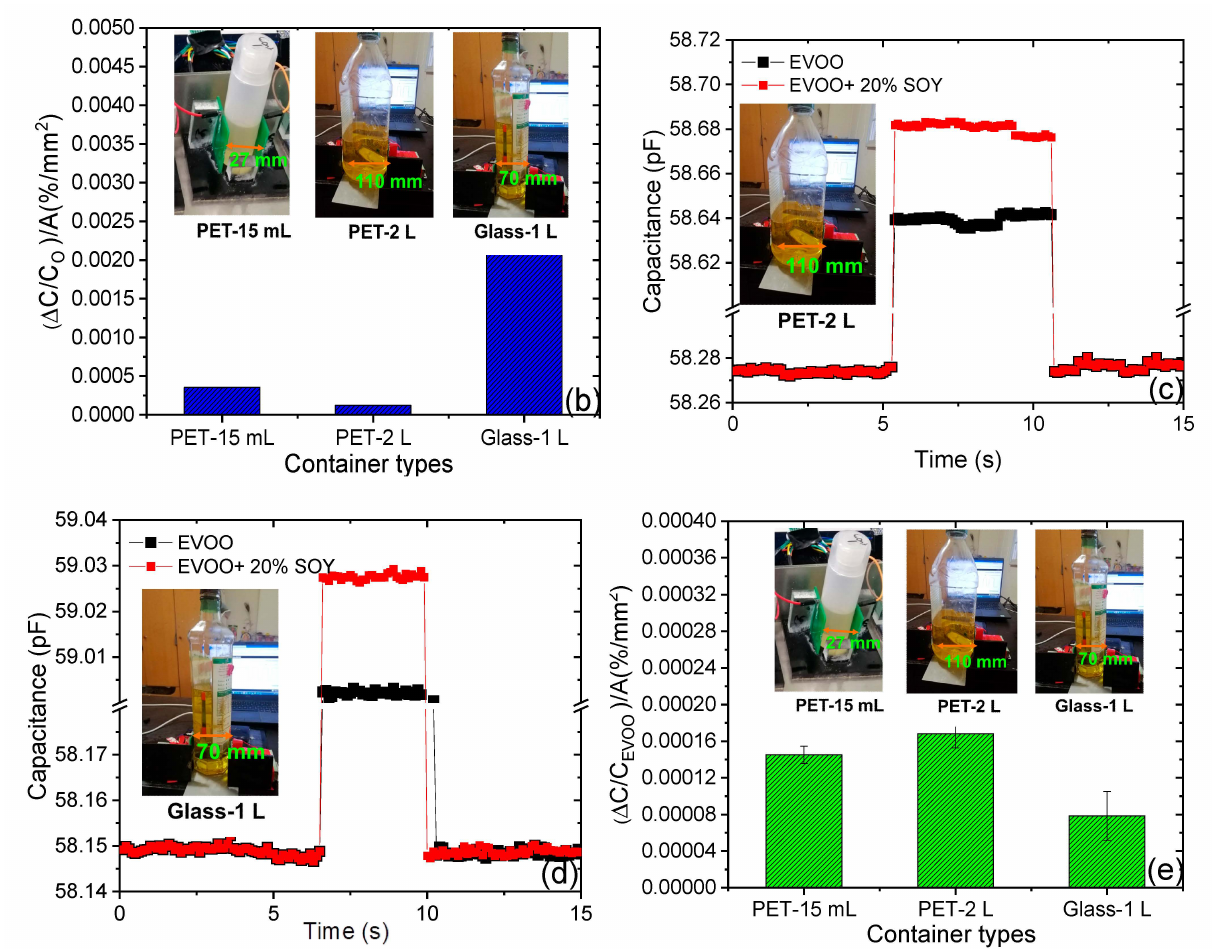
Figure 9. Effect of container type: ( a ) Photograph of the commercially purchased EVOO contain- ers ( left ), photographs of the parallel plate sensor configuration ( top-right ) and PCB fabricated rectangular-shaped sensor electrodes ( bottom-right ). ( b ) ∆ C/C O ( ± σ ) (normalized by sensor area) vs. container type. Capacitance vs time plot of ( c ) 2 L commercial PET EVOO bottle and ( d ) 1 L commercial glass bottle, respectively, before and after blending with 20% SOY. ( e ) ∆ C EVOO /C EVOO ( ± σ ) (normalized by sensor area) vs. container type for EVOO blended with 20% SOY. Extra virgin olive oil − EVOO and soybean oil −